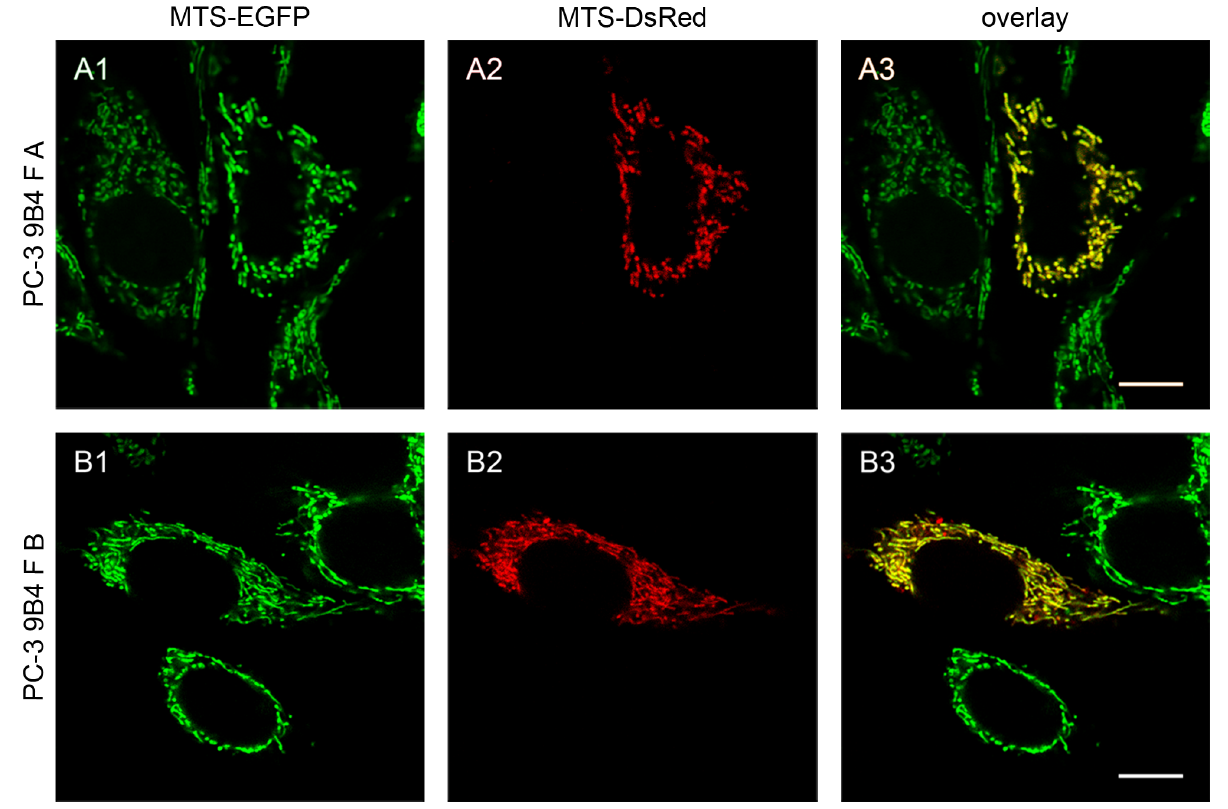
Figure 2. Confocal images of r 0 cells fused with cytoplasts of wild type cells. PC-3 r 0 9B4 cells stably expressing mitochondrial targeted EGFP (MTS-EGFP) were fused with cytoplasts of PC-3 (panel A) or 143B.TK - (panel B) stably expressing mitochondrial targeted DsRed (MTS-DsRed) and were analyzed after 24 h by confocal laser scanning microscopy. Scale bars correspond to 10 m m.